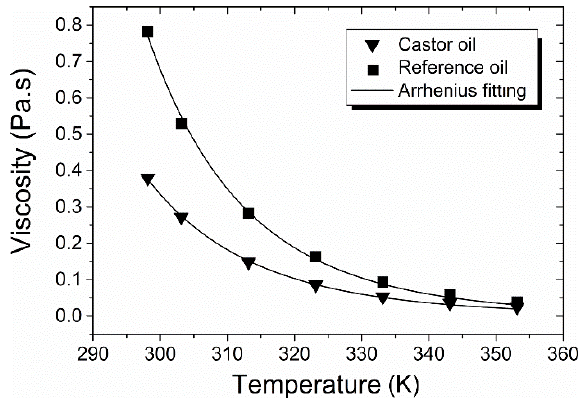
Figure 4. Variation of viscosity with temperature and Arrhenius fittings of Castor and Reference oil. Table 2. Results of nonlinear Arrhenius regressions.